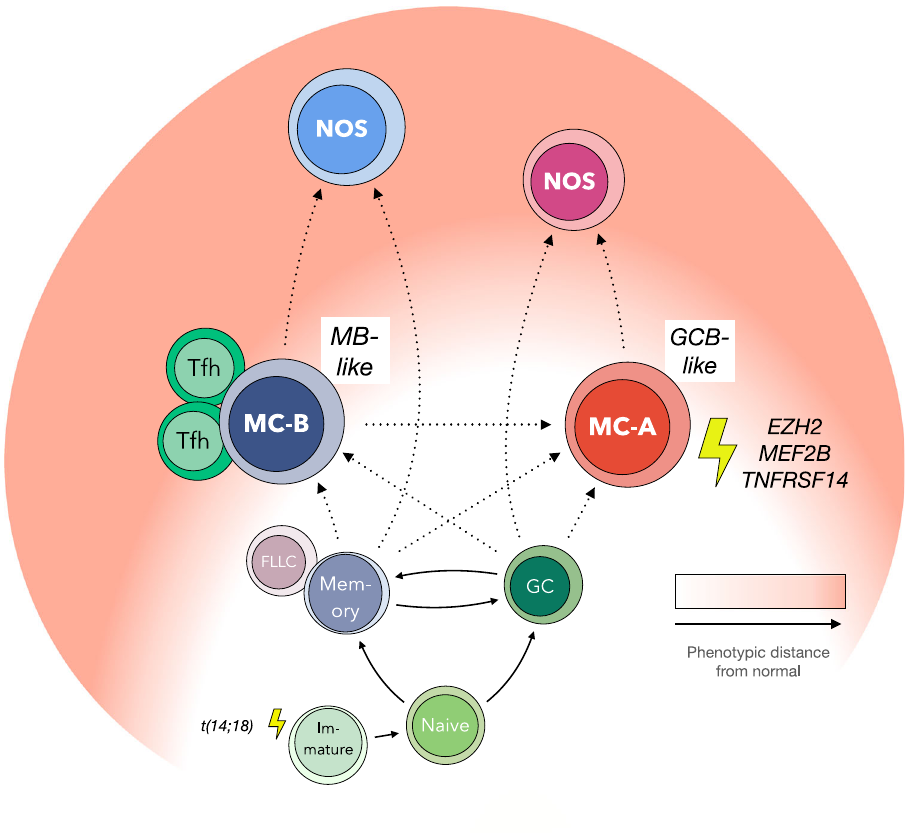
Fig.8|HypotheticalmodelofFLgenesis. MBmemoryB-cell,GCBgerminalcenterB-cell,MCmetacluster,NOSnototherwisespeci fi ed,TfhfollicularhelperT-cell,FLLC follicular lymphoma-like